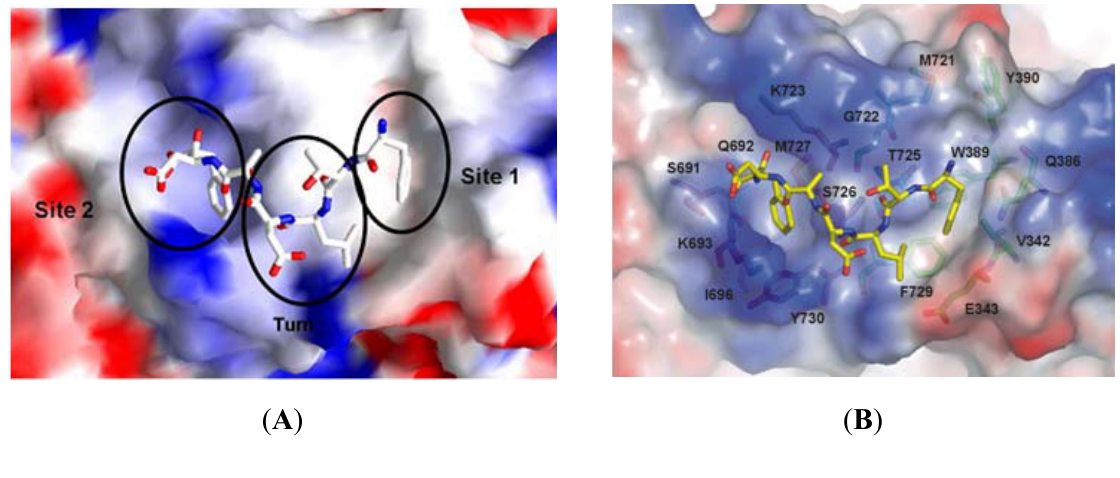
Figure 8. Binding of P7 to ScRR1. ( A ) P7 binds at subsites 1 and 2 connected by a reverse turn ( B ) P7-yellow where subsite 1 is to the right involving F1 and subsite 2 is to the left